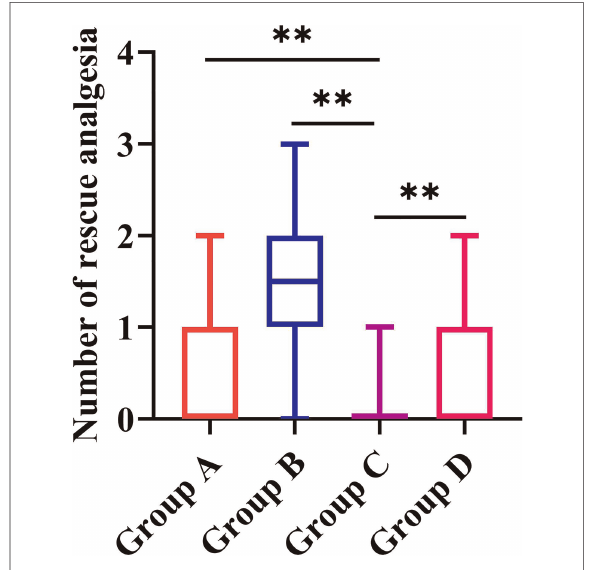
FIGURE 2 The results for rescue analgesia in the four study groups. Group A: administrated with 2 mg morphine hydrochloride; group B: administrated with 0.25 mg/kg of esketamine; group C: administrated with 0.25 mg/kg of esketamine in combination with 2 mg morphine hydrochloride; and group D: administrated with 0.25 mg/kg of esketamine in combination with 1 mg morphine hydrochloride. Data are presented as median (interquartile range). ** P